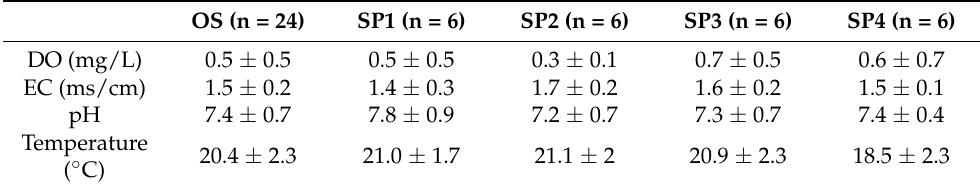
Table 1. Average values of physicochemical parameters